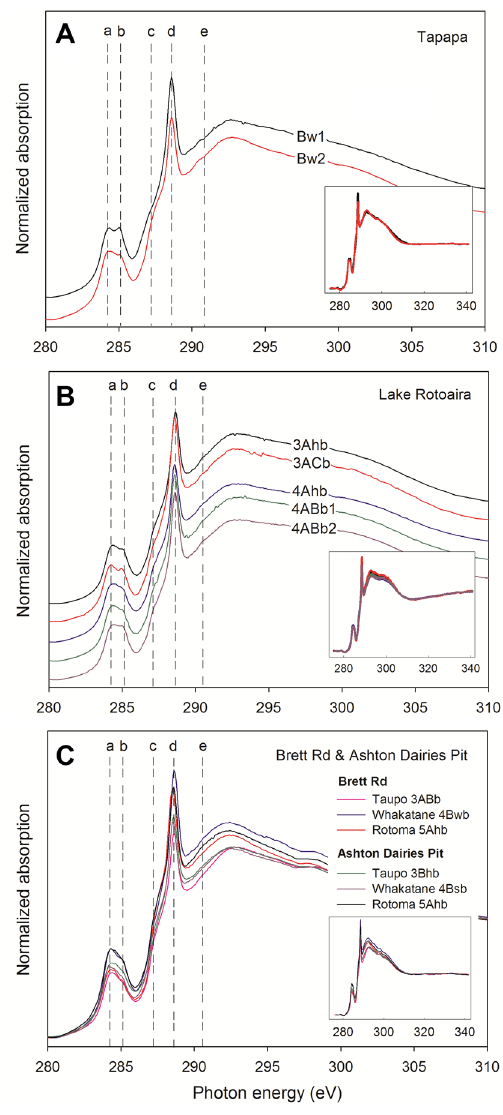
Figure 5. C NEXAFS spectra for organo-clays in allophanic paleosols. ( A ) Clays extracted from the Bw1 horizon (20–30 cm depth) and from the Bw2 horizon (30–40 cm depth) above Rotorua (Rr) tephra at Tapapa. ( B ) Clays extracted from the five soil subhorizons denoted 3Ahb and 3ACb (representing ca 1082 years of soil formation), and 4Ahb, 4ABb1, and 4ABb2 (representing up to ca 8400 years of soil formation) at Lake Rotoaira. ( C ) Clays extracted from upper allophanic soil horizons on Taupo tephra (representing ca 1082 years of soil formation), Whakatane tephra (representing ca 3808 years of soil formation), and Rotoma tephra (representing ca 3897 years of soil formation) at Brett Rd and Ashton Dairies Pit. Spectral features identified by the vertical lines correspond to carbon in (a) quinonic, (b) aromatic, (c) aliphatic, (d) carboxylic/carbonyl, and (e) carbonyl/ carbonate functional groups (Fig. 1). Note there were cartographic shifts of spectra in both ( A ) and ( B ) graphs to show each spectrum clearly, but no shift in graph ( C ) in order to observe the difference of intensity of X-ray absorbance between samples collected from the two near-adjacent sites. The small insets show the full spectra including pre-edge and post-edge regions to indicate proper spectrum